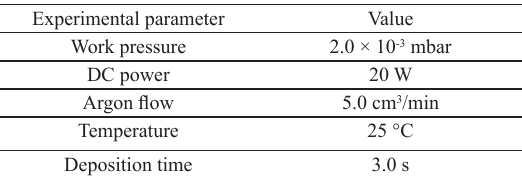
Table 1. Experimental parameters used for silver deposition on NRL films. Experimental